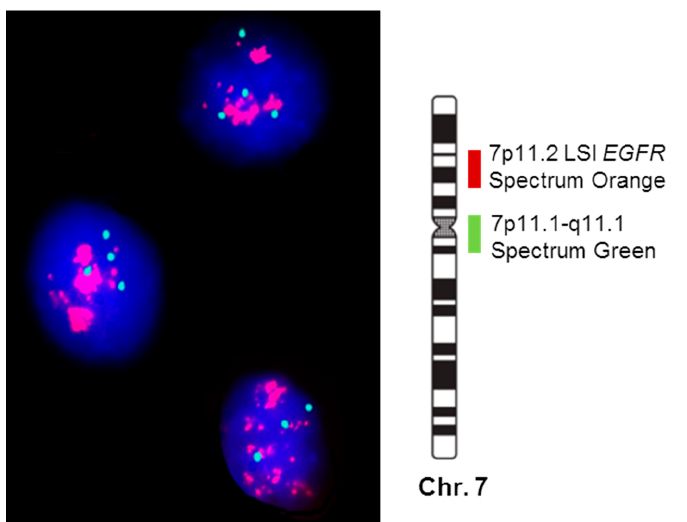
Figure 2. Interphase nuclei with the amplified EGFR gene detected by FISH techniques from a biopsy sample of a patient with squamous cell carcinoma of the lung (probes for identifying chromosome 7 centromere (7p11; green spots) and EGFR gene (7p11.2; red spots)).